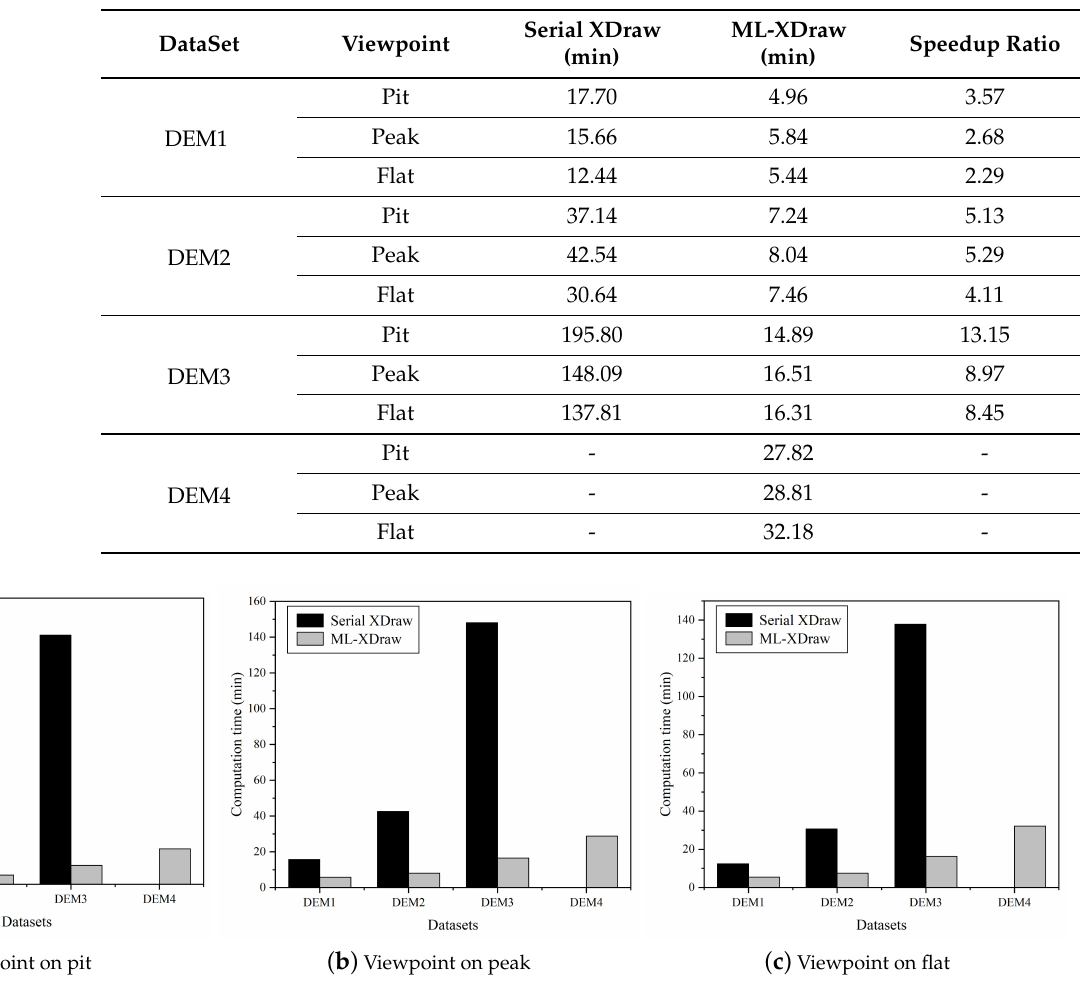
Figure 11. Comparisons of the computation time of two